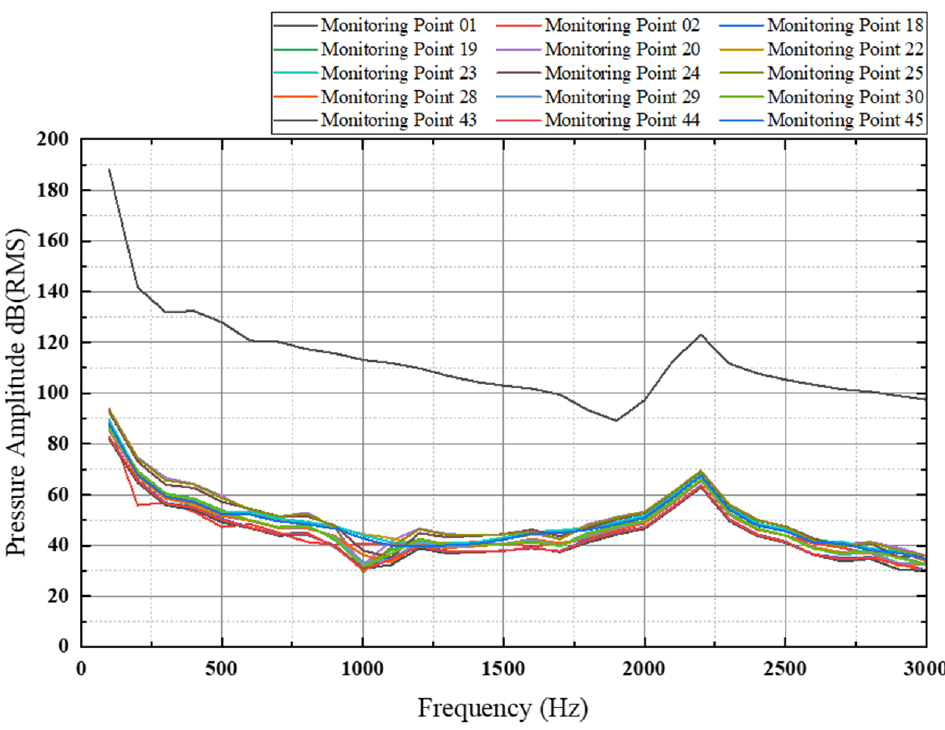
Figure 30. Line graph of the frequency response curve of the 3000 Hz far-field sound pressure level of the standard